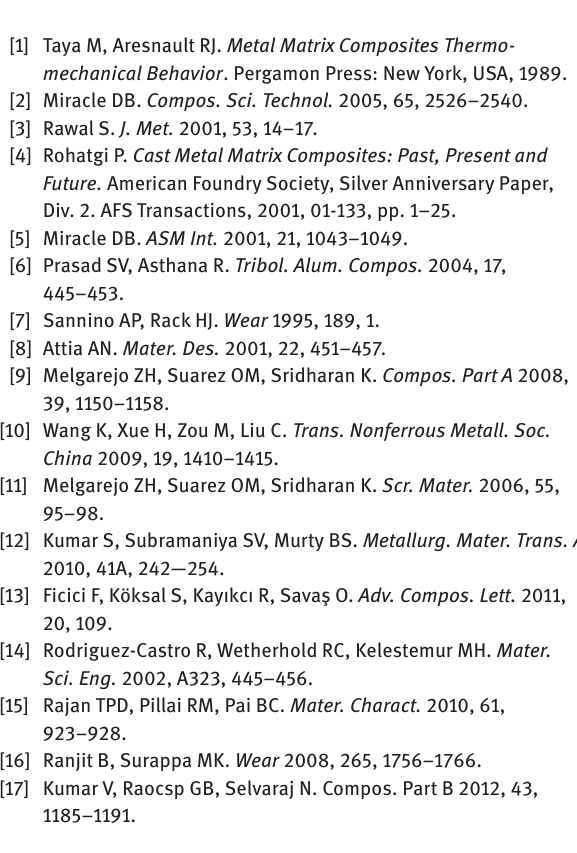
Figure 8 Average cumulative wear volume loss of the composite.